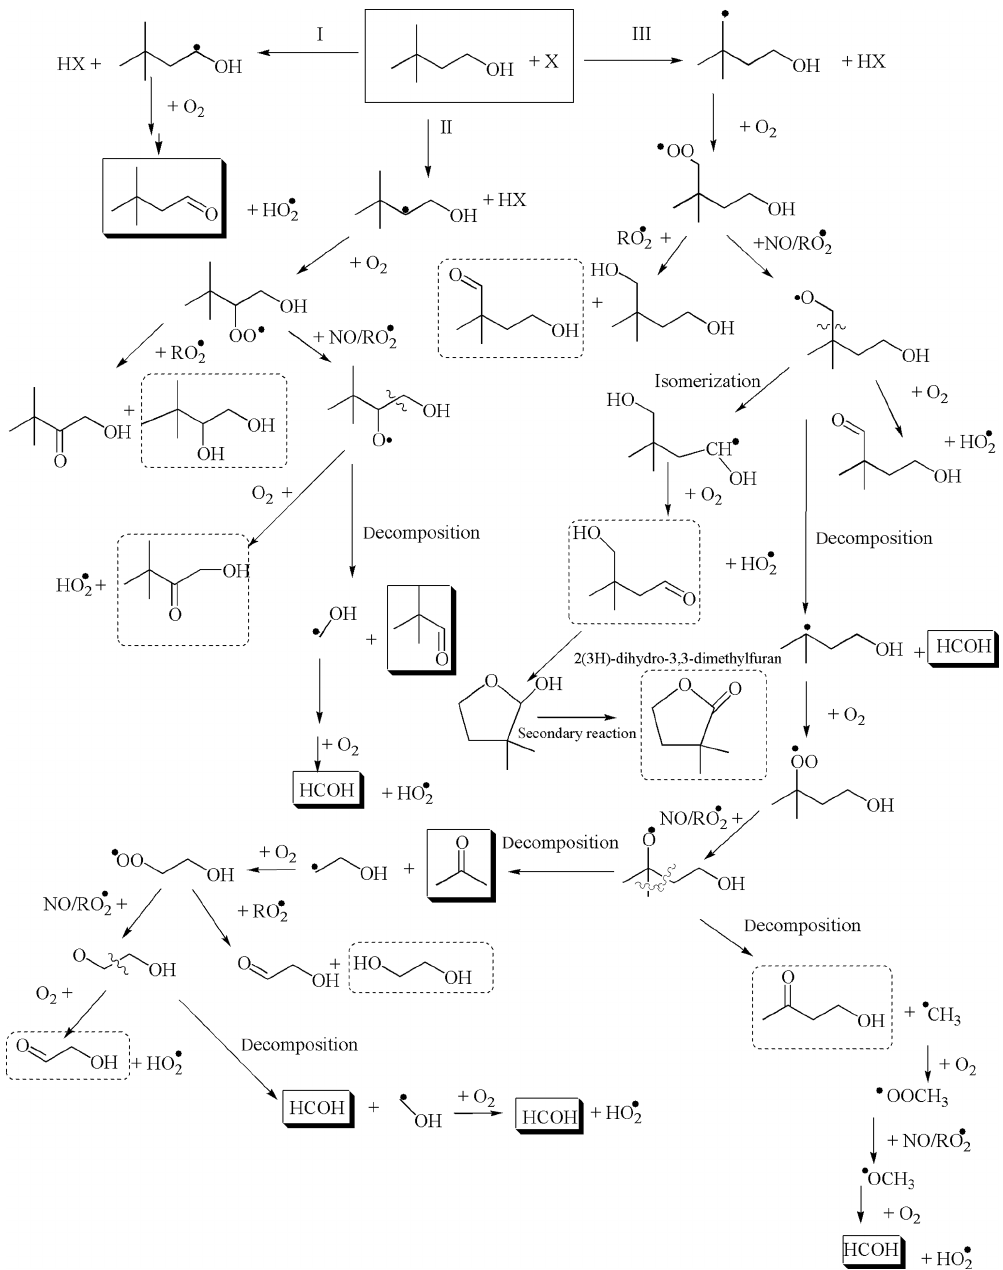
Figure 7. Reaction mechanism for the degradation of 3,3DM1ButOH with X (the Cl atom and the OH and NO 3 radicals). The mechanism for the formation of carbonyl compounds. Compounds marked with a solid line are positively identified. Compounds marked with a dotted line are not positively